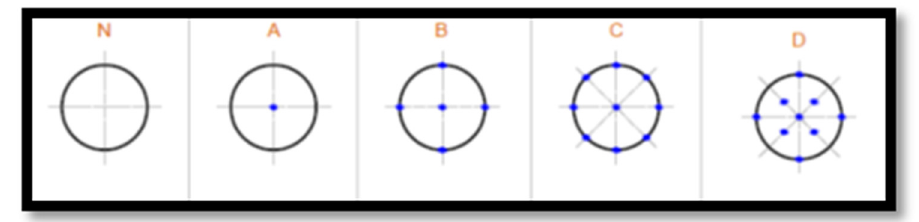
Figure 4: Grouting spacing before footing construction with a depth of grouting equal to d ′ .